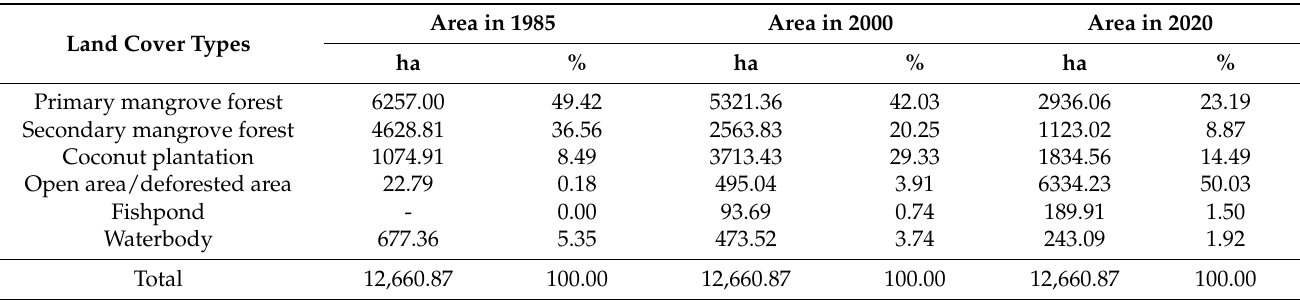
Table 4. Area of land cover types in ATPF in 1985, 2000, and 2020.